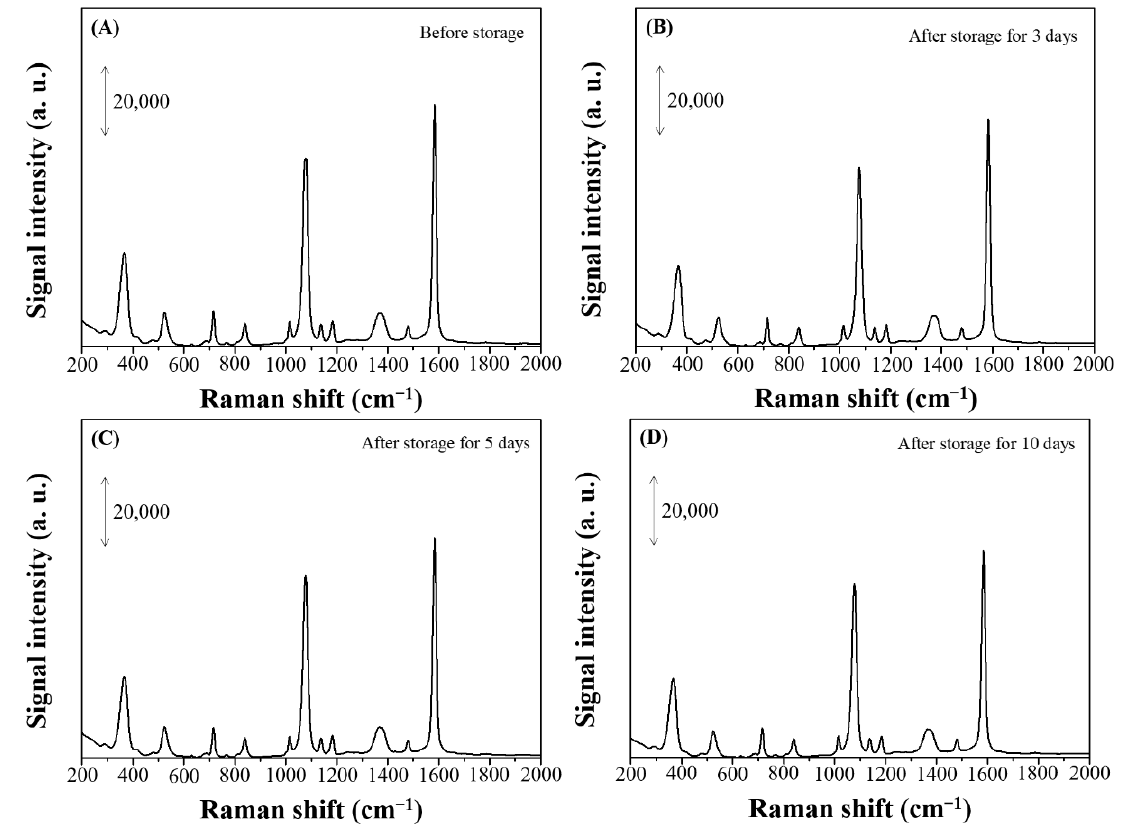
Figure 10. The SERS spectra of 4-MBA (100 µM) adsorbed on the dendritic forest-like Ag nanostructures ( A ) before and after storage for ( B ) 3, ( C ) 5 and ( D ) 10 days.